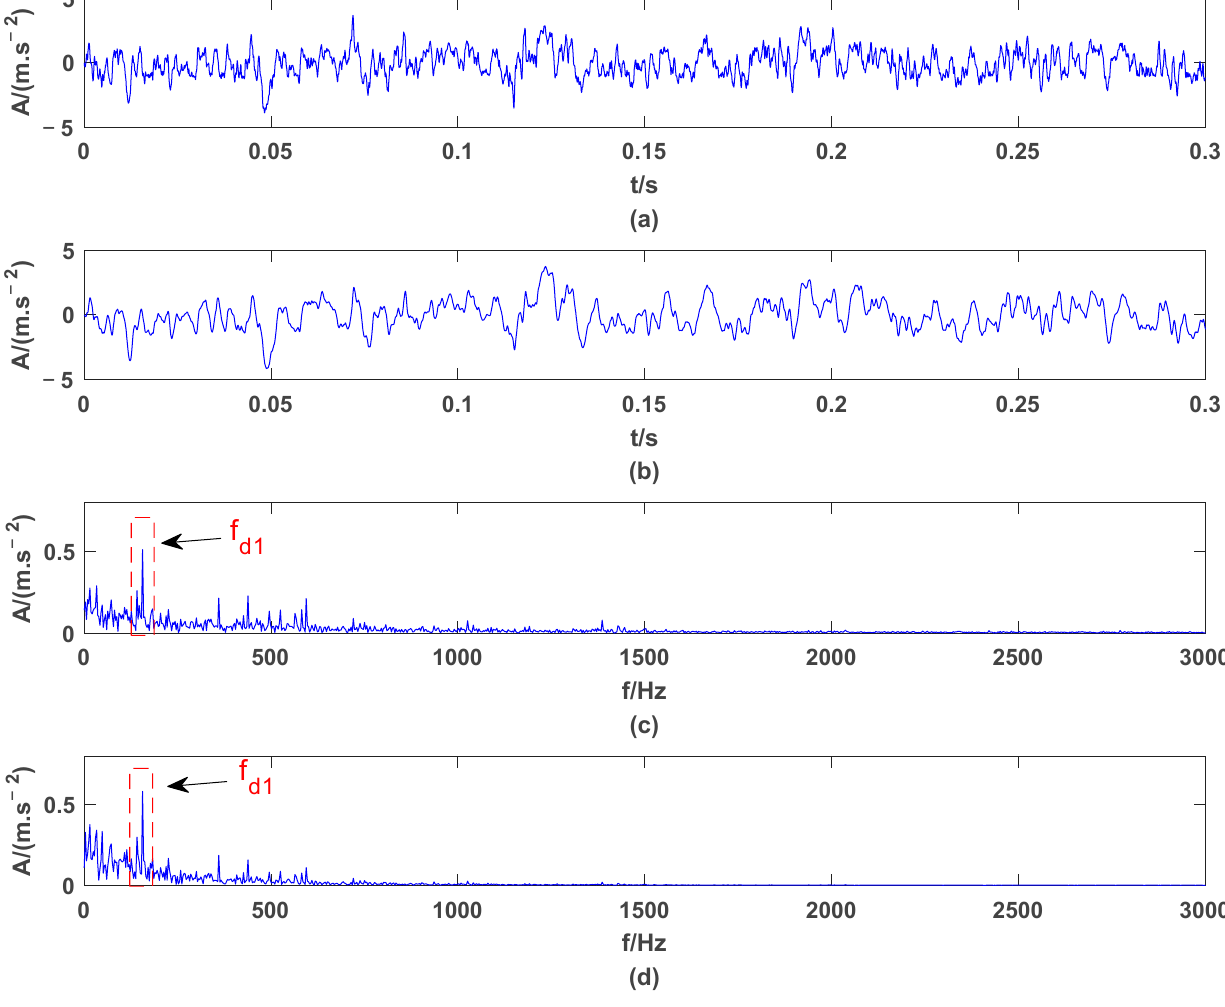
Figure 7. The output signal of SKF 6205-2RSJEM ( a ) time domain curve of the PTSR system ( b ) time domain curve of PTSR method in the underdamped state ( c ) frequency domain curve of PTSR method ( d ) frequency domain curve of PTSR method in the underdamped state.